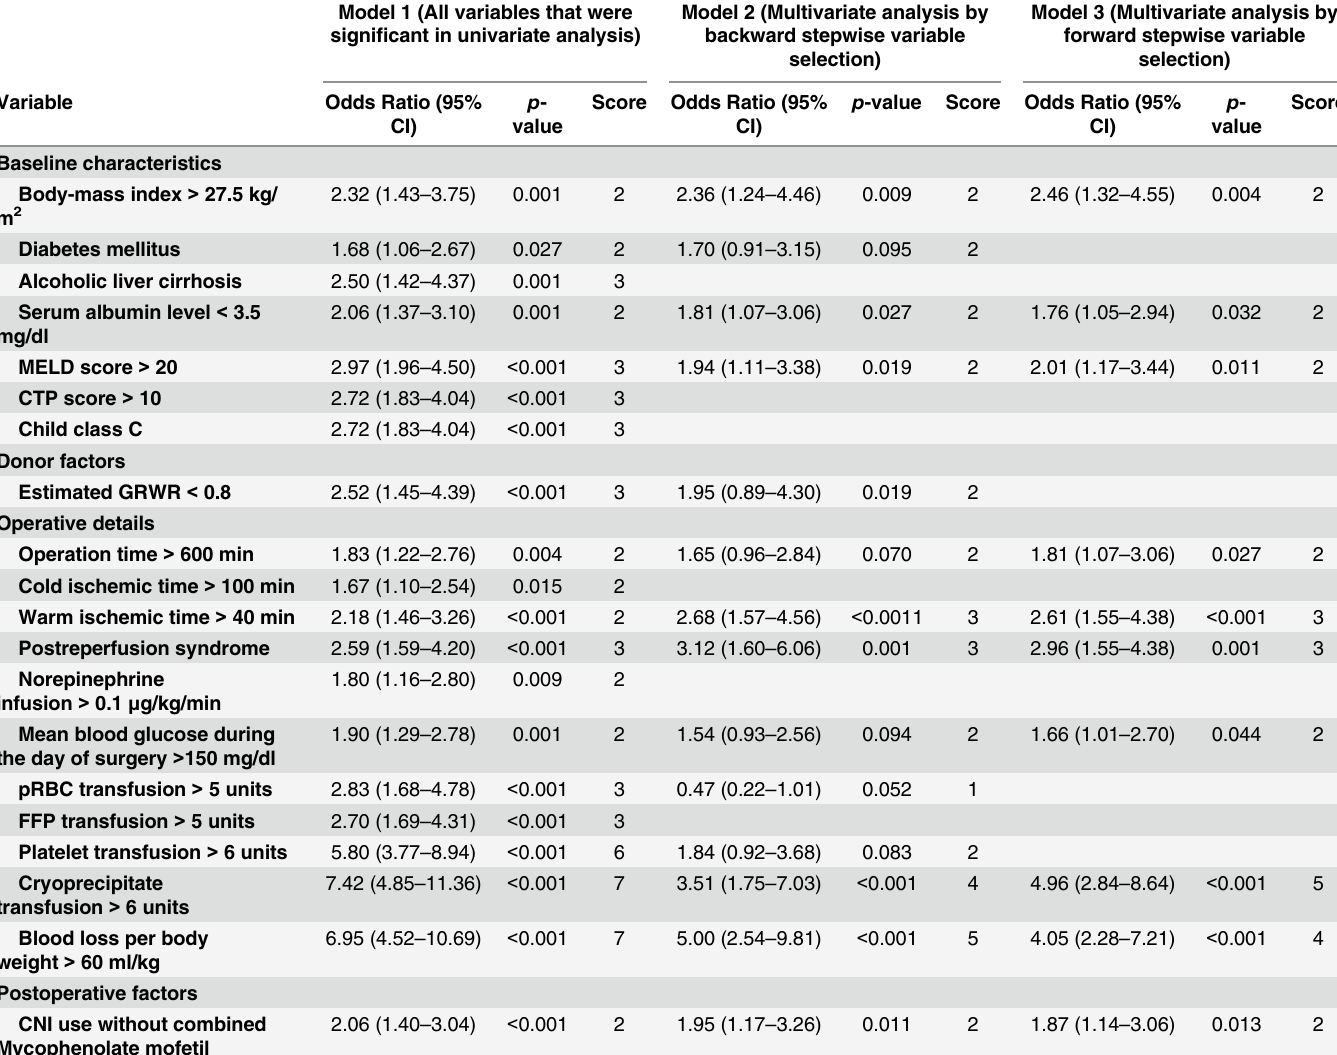
Table 2. Logistic regression analyses of categorized risk factors for acute kidney injury within all RIFLE classification. Model 1 (All variables that were signi fi cant in univariate